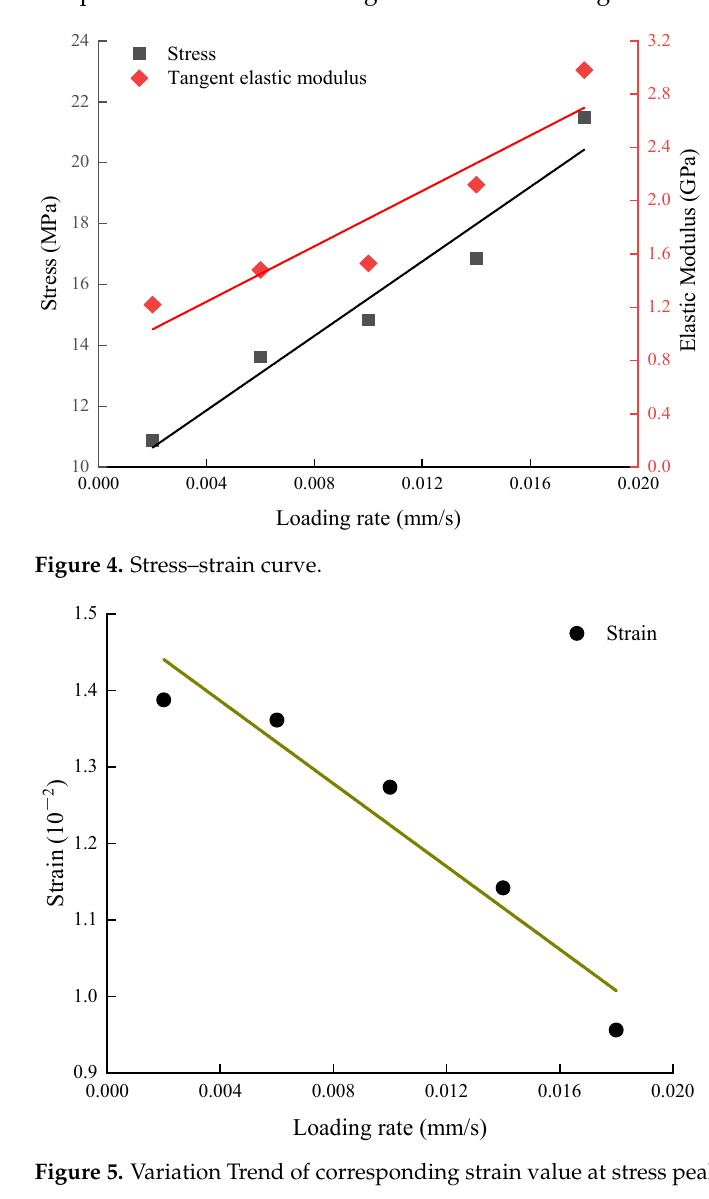
4 of 14 Figure 3. Stress–strain curve.